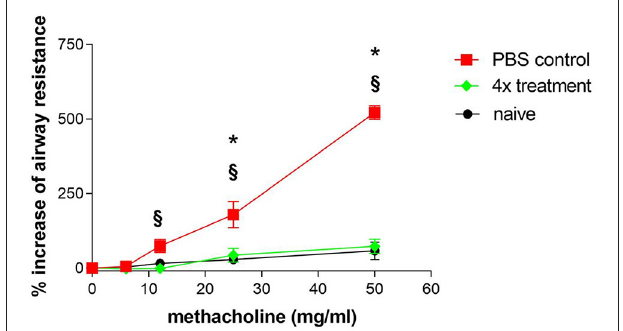
FIGURE 4 | Airway hyper-reactivity as one hallmark of asthma is efficiently treated by SCIT. Airway hyper-reactivity: Measurement of airway hyper-responsiveness in sensitized and challenged mice (PBS control) and in sensitized, challenged and four times treated mice (4 × treatment). Naïve mice were untreated. Airway resistance was measured in intubated spontaneously breathing mice. Each symbol represents mean ± SEM, four mice per group were measured. * p < 0.05 for 4 × treatment compared to PBS control, § p < 0.05 for naïve mice compared to PBS control, determined by unpaired Mann-Whitney